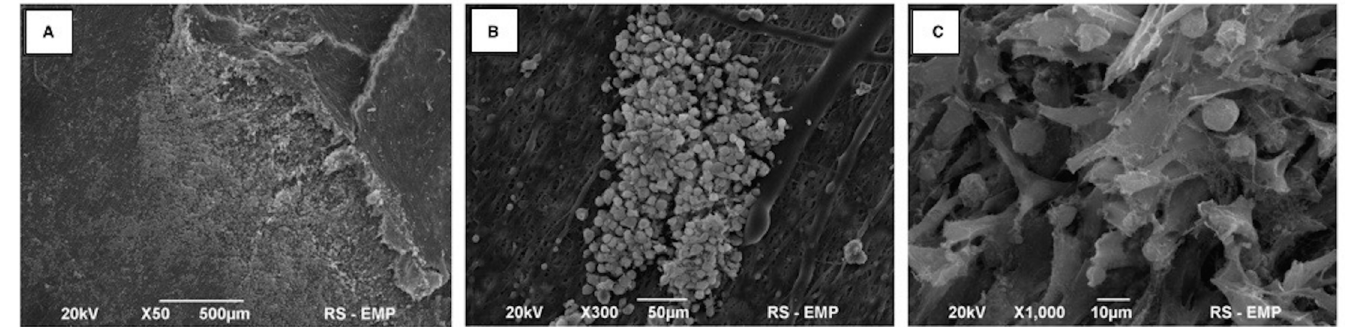
Fig 2. Cytotoxity testing of biocomposite using MSC. (A) MSC migrating towards Am on the 7 th day of in vitro cultivation. (B) Clusters of MSC distributed on an external surface of a PLCL membrane. (C) Dispersed MSC adherent to PLCL nanofibers.